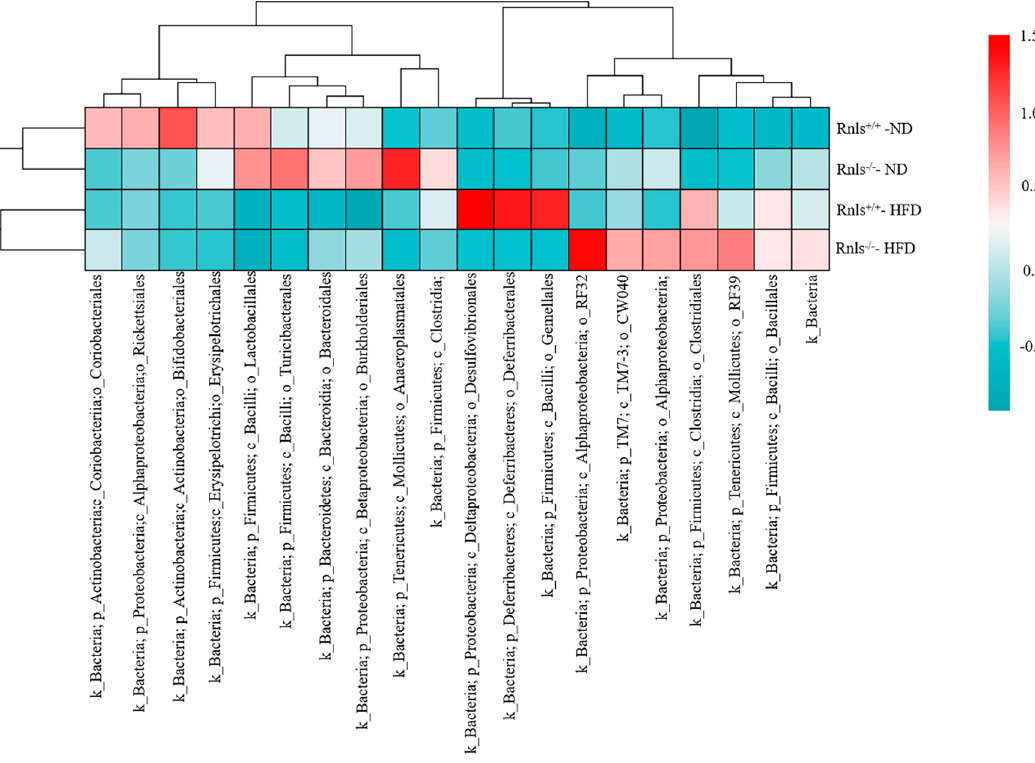
Figure 7. Heatmap of identified orders of dominant species among the four groups. The 20 species at the order level shared by all samples tested (core microbiome) are displayed. Rnls − / − -ND, renalase gene knockout mice fed with normal diet; Rnls +/+ -ND, wild-type mice fed with normal diet; Rnls − / − - HFD, renalase gene knockout mice fed with high-fat diet; Rnls +/+ -HFD, wild-type mice fed with a high-fat diet.